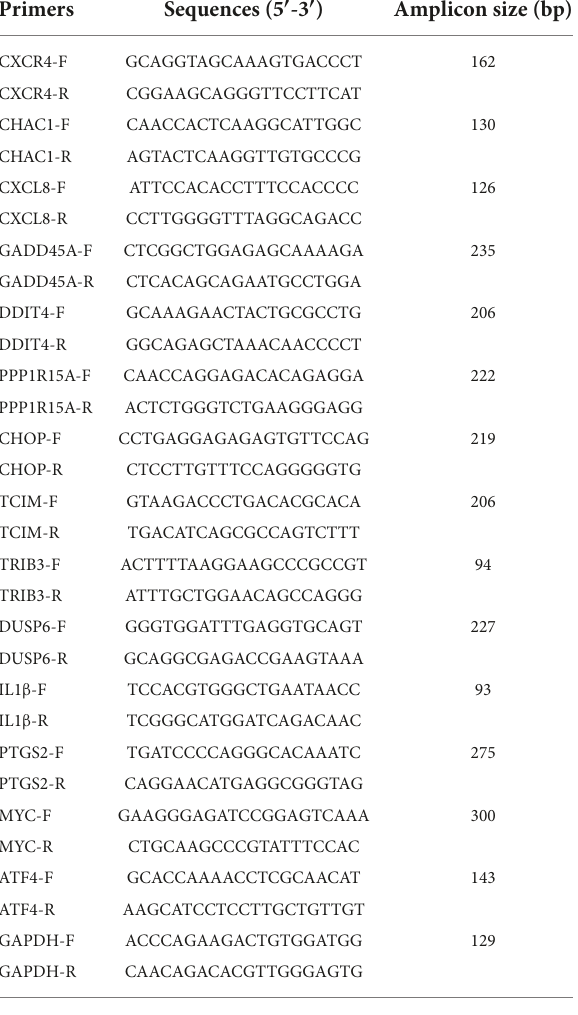
TABLE 1 The primers used for qRT-PCR in this study.